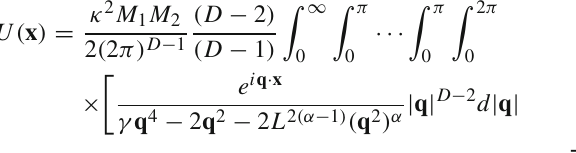
Fig. 1 The tree-level diagram of two scalar particles interacting via the exchange of a